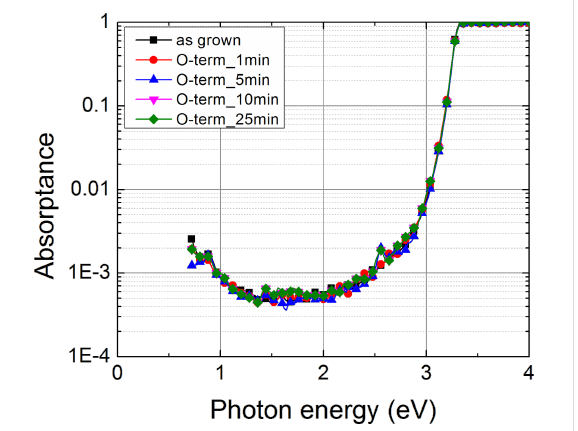
Figure 3: The optical absorptance spectra of as-grown ZnO nanocol- umns and NCs treated in H-plasma for 1, 5, 10 and 25 min.